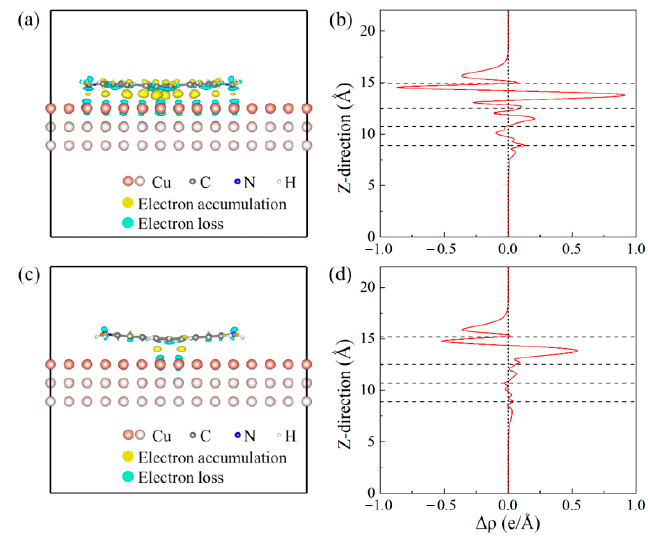
Figure 3. ( a , c ) The EDD maps of configurations a and h with iso-surfaces of Δρ = ±0.027 e/Å 3 . The yellow regions indicate the electron accumulation, while blue regions indicate the electron loss. ( b , d ) The integrated electron density difference figures of configurations a and h in z direction. The electron transfer in the configuration a is larger than in the configuration h. The black dashed lines represent the relative positions of the DAT molecule and three Cu layers in the z direction. Nega- tive Δρ means electron loss, while positive Δρ means electron accumulation. The electronic density of states (DOS) of a freestanding DAT molecule and the pro- jected DOS of the configuration a have been plotted in Figure 4 to obtain further insights into the DAT/Cu(001) system. The DAT molecule on a Cu(001) surface has similar elec- tronic states with a freestanding one at low energy levels. However, there is no electronic state around the Fermi level for a freestanding DAT molecule (Figure 4a), while the DOS projected on the DAT molecule adsorbed on a Cu(001) surface (see Figure 4b) exhibits a metallic character, showing a strong interaction between the DAT molecule and the Cu(001) surface. The inset figures in Figure 4b give the projected DOS around the Fermi level on benzene rings and a N atom of the configuration a. Comparing the projected DOS on benzene rings on different adsorption sites (the upper inset figure), the benzene ring on a hollow site has larger states than that on a bridge site around the Fermi level, indicating a stronger interaction with the Cu(001) surface. The lower inset figure shows the interaction between the N atom and the surface.